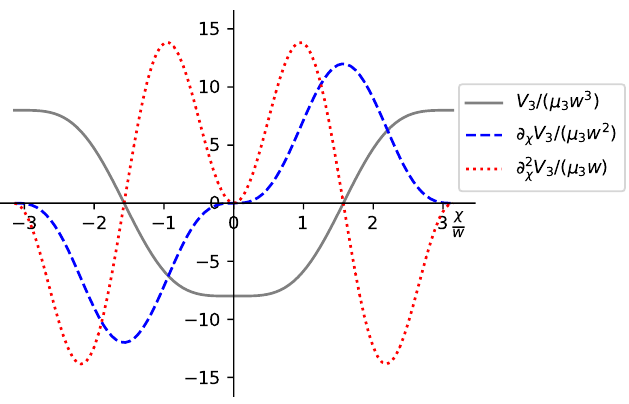
Figure 3 . The potential, V 3 , and its (cid:12)rst two derivatives with respect to (cid:31) at s = 0 for (cid:22) 0